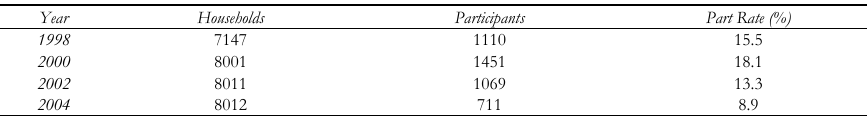
Participation Rates for Total